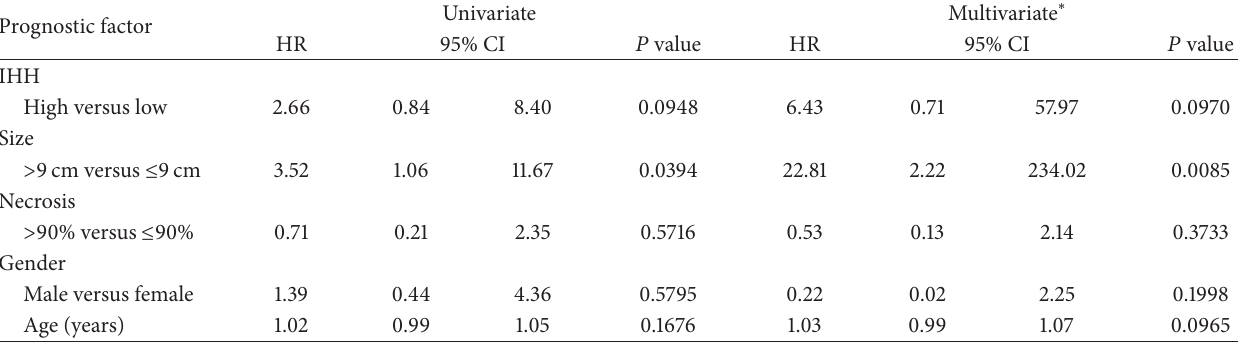
Table 2: Results of DFS analysis by Cox Proportional Hazards model in no metastasis at diagnosis group (𝑛 = 32) for IHH. Prognostic